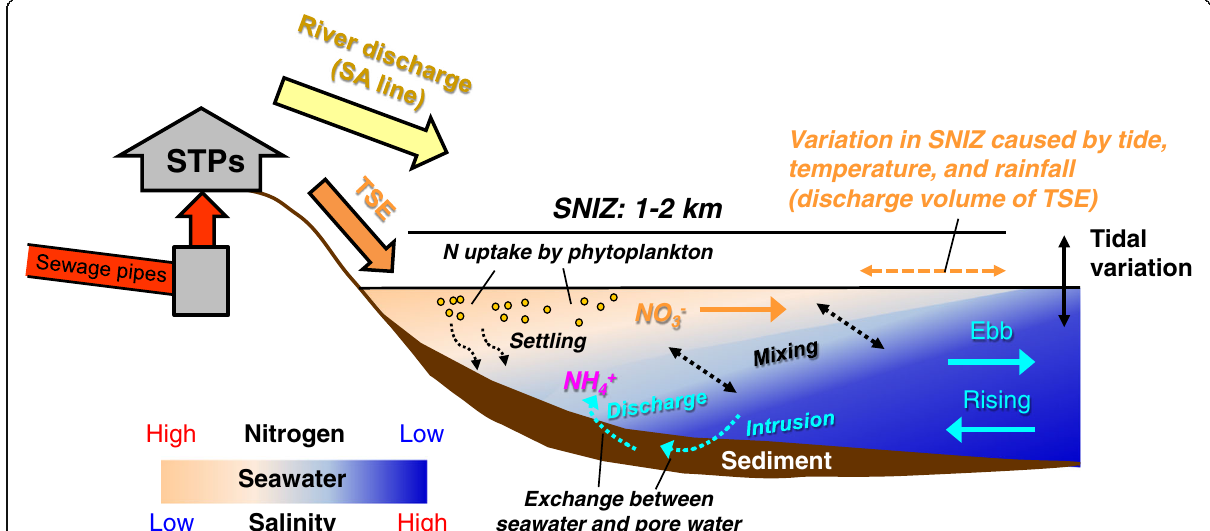
Fig. 8 Schematic diagram of nitrogen dynamics in the coastal sewage-derived nitrogen impact zone (SNIZ). Solid and broken arrows show water movement and suggested processes from the present research,